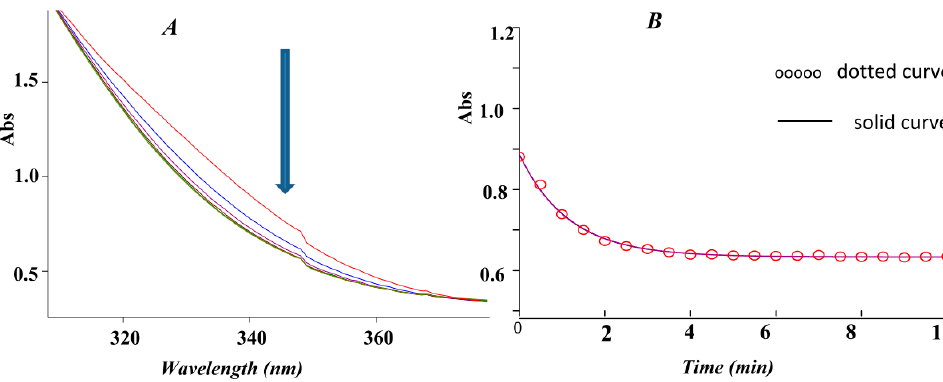
Figure 2. ( A ) The UV-VIS spectra for the reaction between TPP (5.00 × 10 − 3 M), DMAD (5.00 × 10 − 3 M) and MA (5.00 × 10 − 3 M); the downward direction of the arrow indicates the reaction progress; ( B ) The original experimental absorbance change (dotted curve) along with the second-order fit curve (solid curve) against time at 320 nm and 20.0 °C in ethanol.